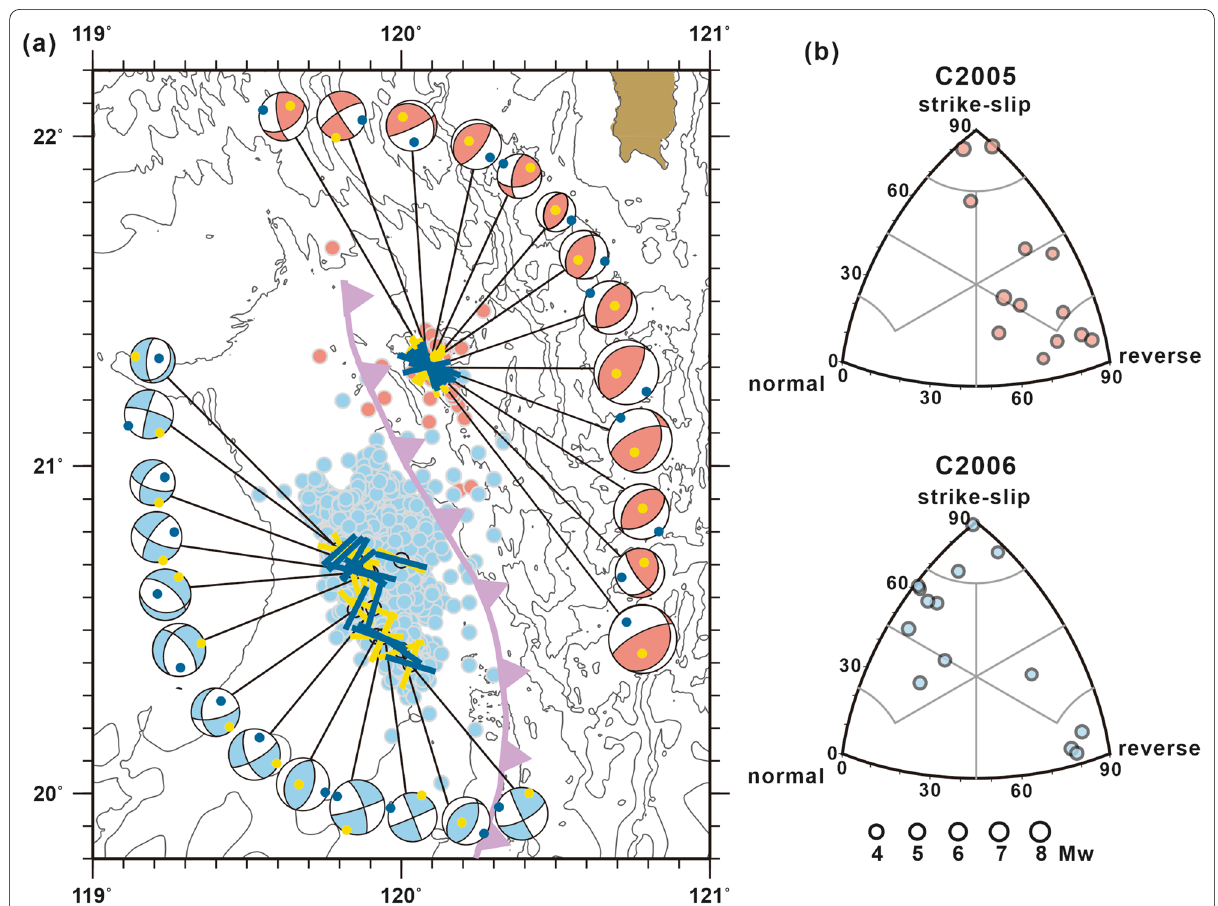
Fig. 7 a Focal mechanism solutions determined in this study. The mechanical P- and T-axes are shown as blue and yellow dots on the beach balls and are projected onto the horizontal surface at their epicentral locations. b Mechanical classification